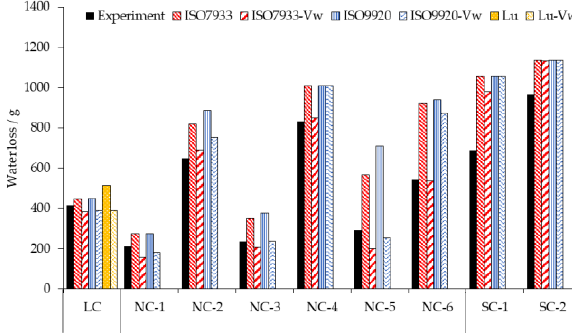
Figure 6. The water loss for three types of clothing observed on participants (Experiment) and calculated by the PHS model with clothing correction algorithm of ISO 7933, ISO 9920, and Lu on adding the walking speed input parameter (ISO7933- v w , ISO9920- v w , Lu- v w ).